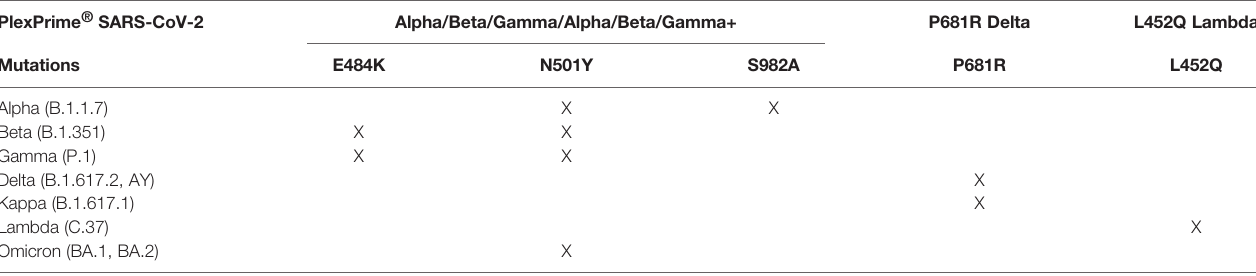
TABLE 1 | VBM and VOC spike gene mutations detected in SARS-CoV-2 PlexPrime ® assays 1 . PlexPrime ®